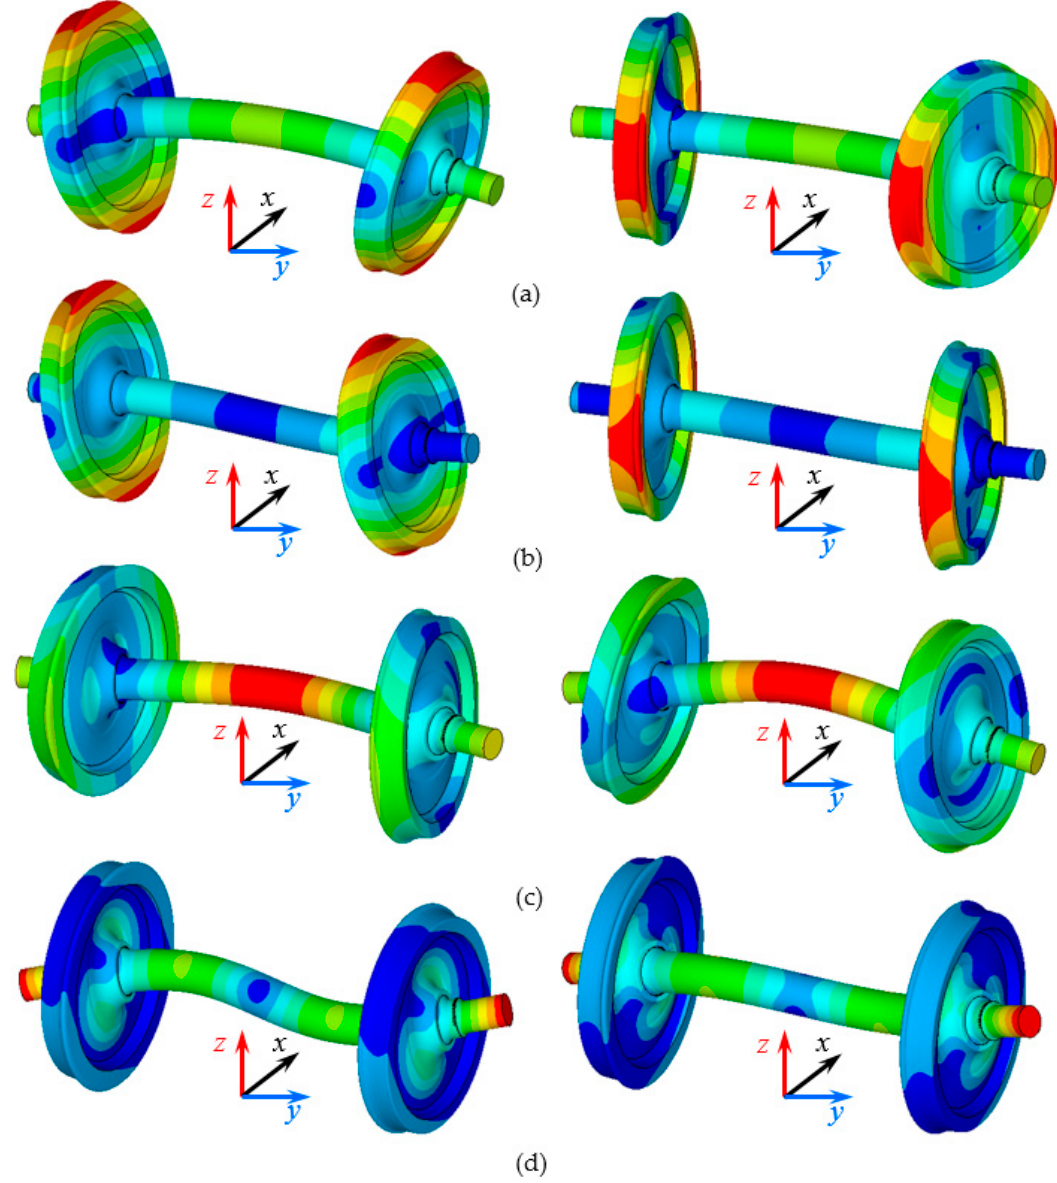
Figure 8. Bending modes of wheelset (0–800 Hz): ( a ) First bending mode at 87 Hz; ( b ) Second bending mode at 143 Hz; ( c ) Third bending mode at 284 Hz; ( d ) Fourth bending mode at 576 Hz.